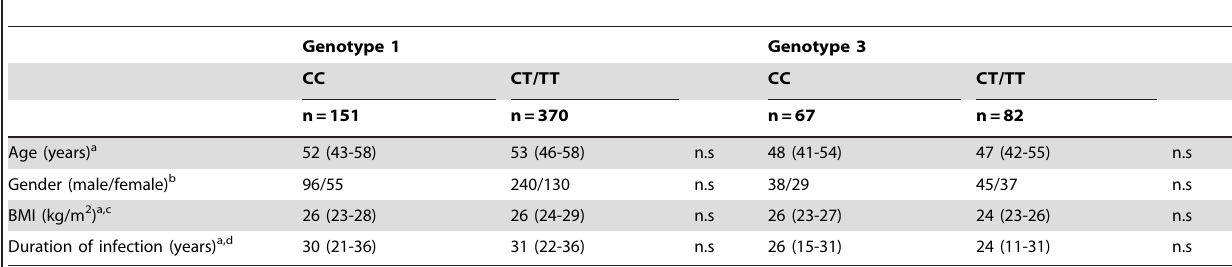
Table 2. Baseline characteristics according to HCV genotype and IL28 B genetic variations ( rs12979860 ).